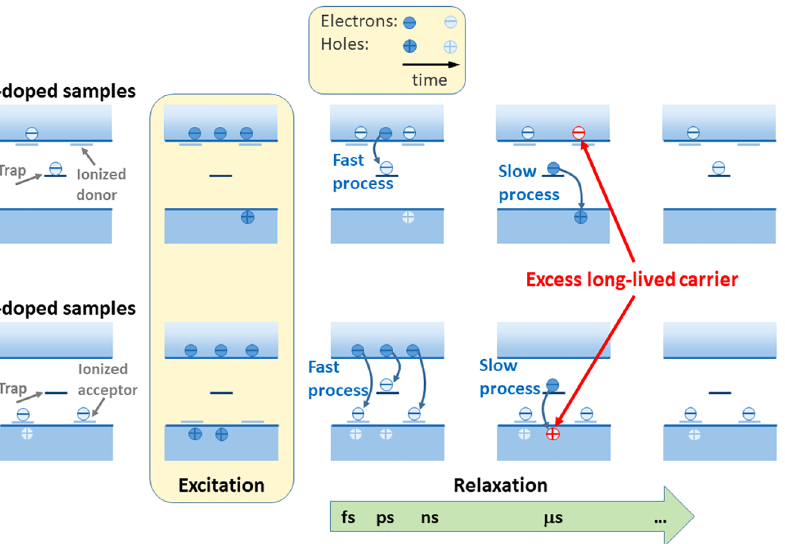
Figure 6: Occupation of bulk-like traps in n -doped and p -doped TMDs before, during, and after excitation with a laser pulse. Free electrons (excitons) are captured by traps within ns. All the radiative recombination (not shown in this sketch) takes place by then. The capture of electronsbytrapsisafastprocess,asopposedtotherelaxationofelectronsfromthetrapstothevalencebandwhichisaslowprocess.Dueto the occupation of traps by electrons, we have excess electrons in the n -doped sample and excess holes in the p -doped sample (red electrons and holes). These are long-lived carriers that are detected in time-resolved microwave